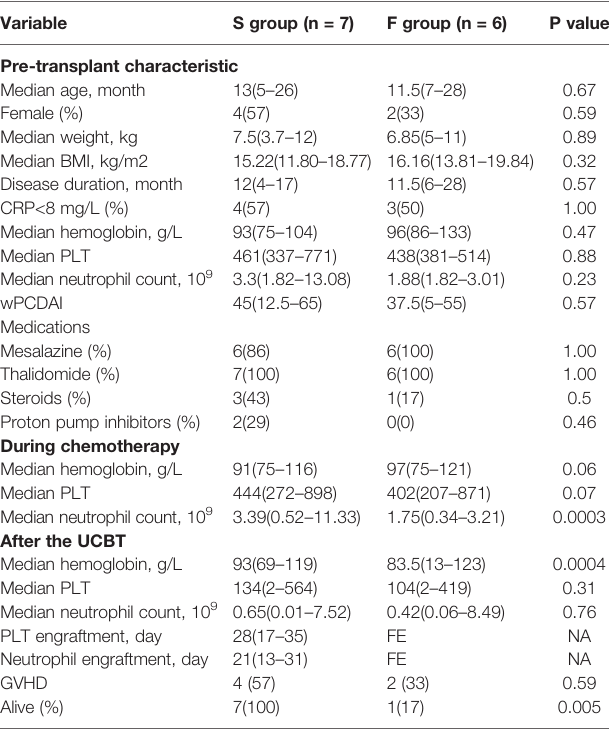
TABLE 1 | Characteristics of IL10RA -de fi ciency patients receiving umbilical cord blood transplantation.